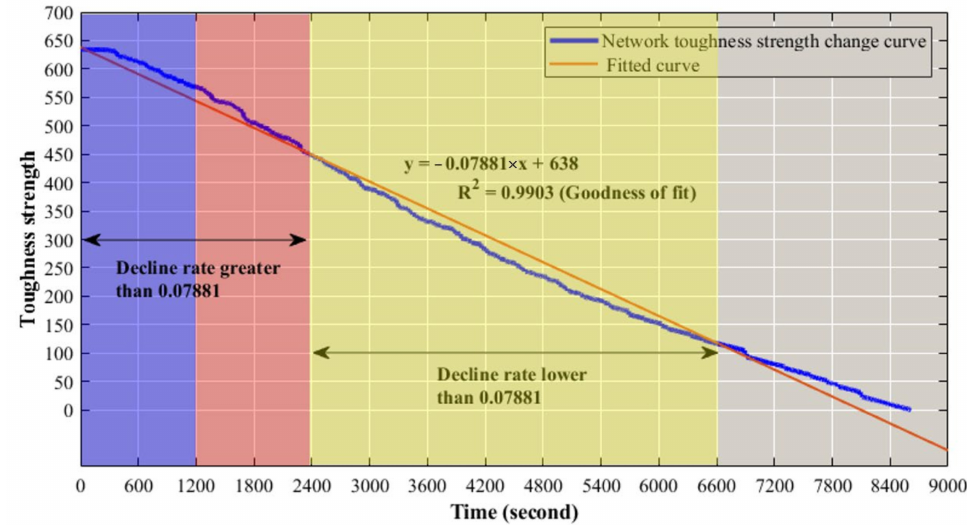
Figure 17. Network toughness strength